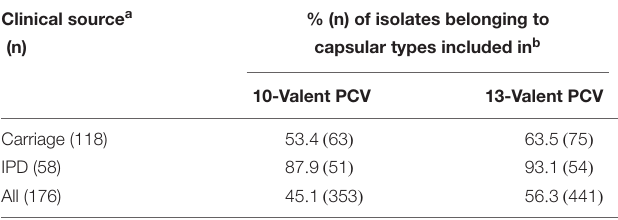
TABLE 4 | Distribution of capsular types included in pneumococcal conjugate vaccines currently available among 176 Streptococcus pneumoniae isolates non-susceptible to penicillin (PNSP) according to the clinical